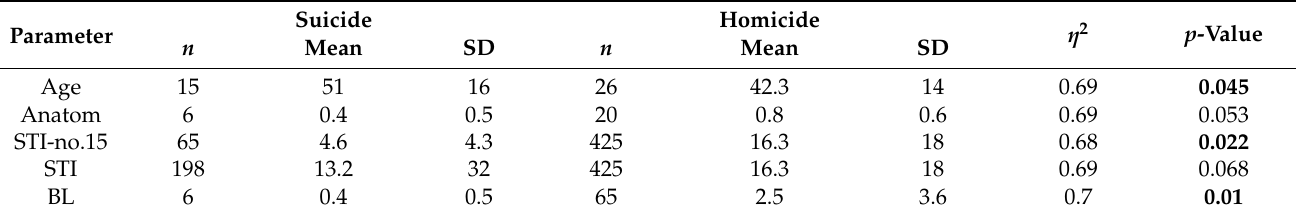
Table 8. Eta ( η ) 2 - and p -values of Mann-Whitney-U tests.